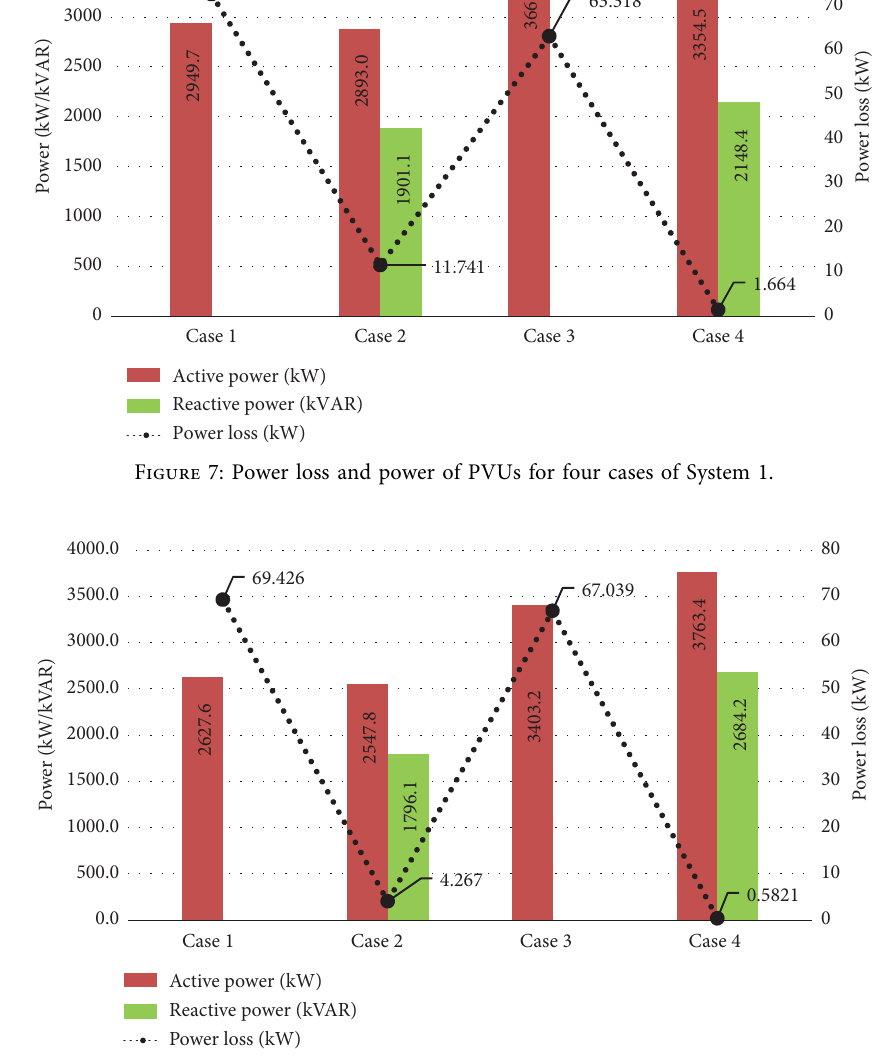
Figure 8: Power loss and power of PVUs for four cases of System